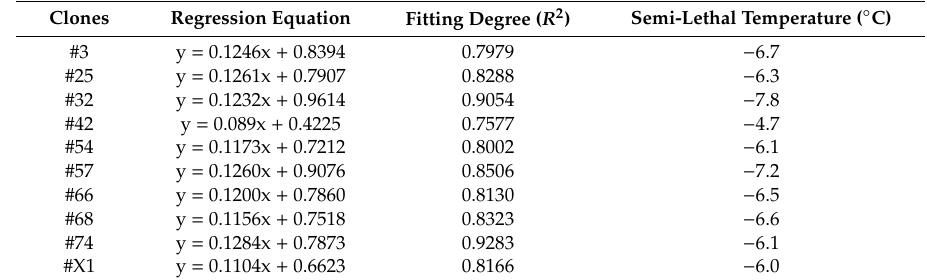
Table 2. Regression equation of electrolyte leakage and temperature and semi-lethal temperature of C.